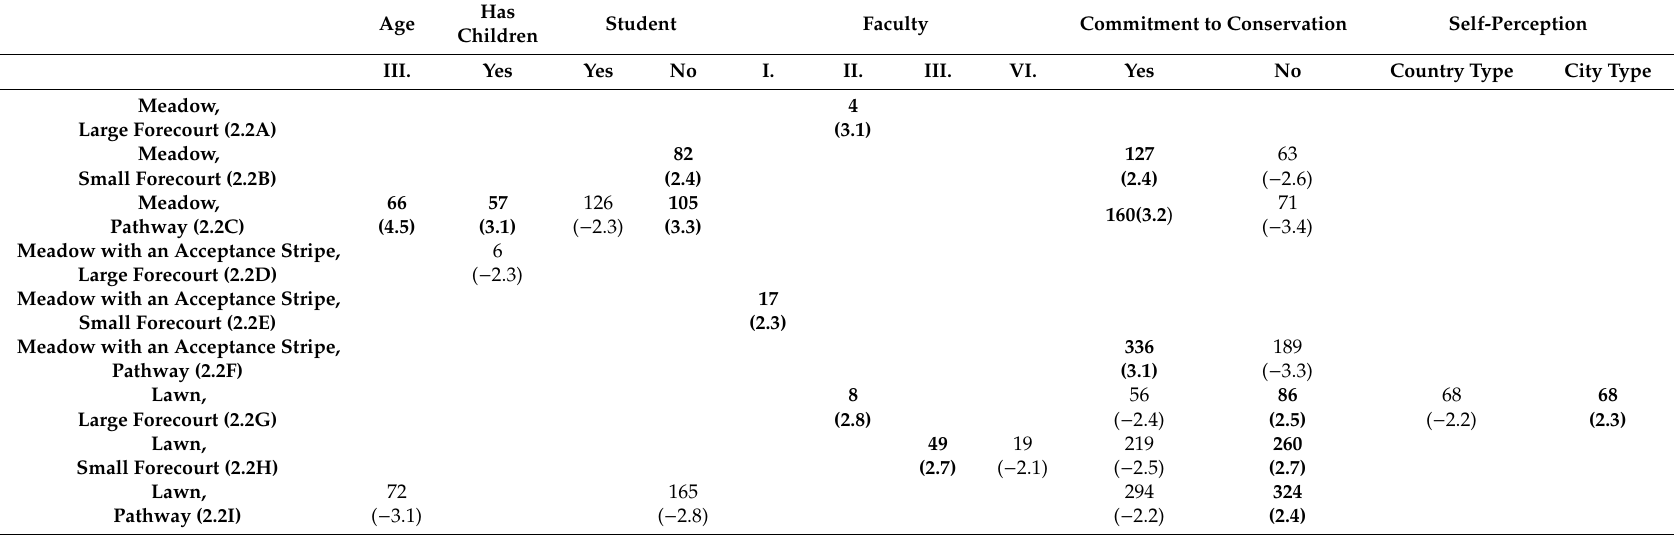
Table 4. Question 2.2 compared natural late summer meadows (2.2A, 2.2B, 2.2C, 2.2D, 2.2E, and 2.2F) with lawns (2.2G, 2.2H, and 2.2I). The meadows were illustrated with (2.2D, 2.2E, and 2.2F) and without (2.2A, 2.2B, and 2.2C) an acceptance stripe. All green spaces were presented with variation in the degree of overgrowth: